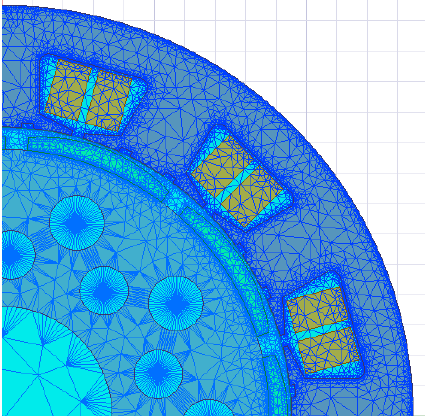
Figure 8. The ideal model of the PMSM.